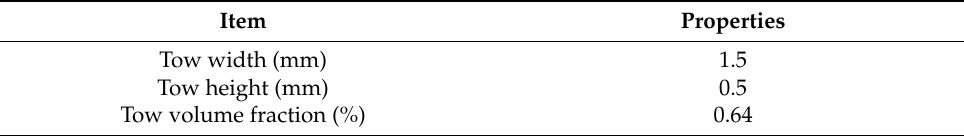
Table 1. 1 Properties of fiber reinforcement.